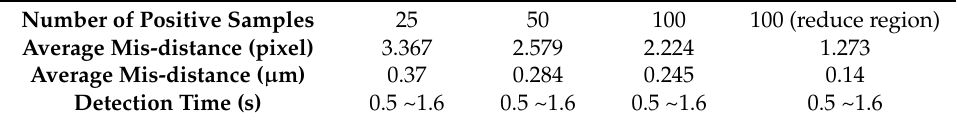
Table 2. Mean error of light spot positioning with different sample numbers.